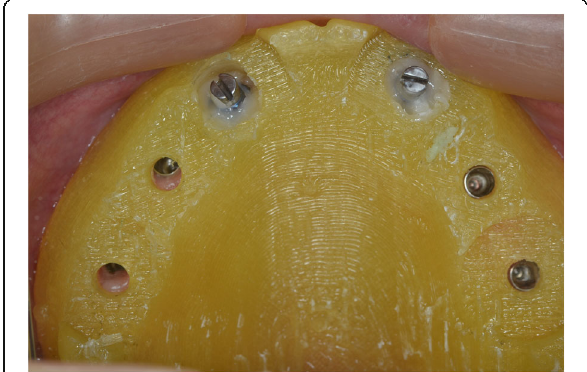
Fig. 10 Bite registration material was used to record centric